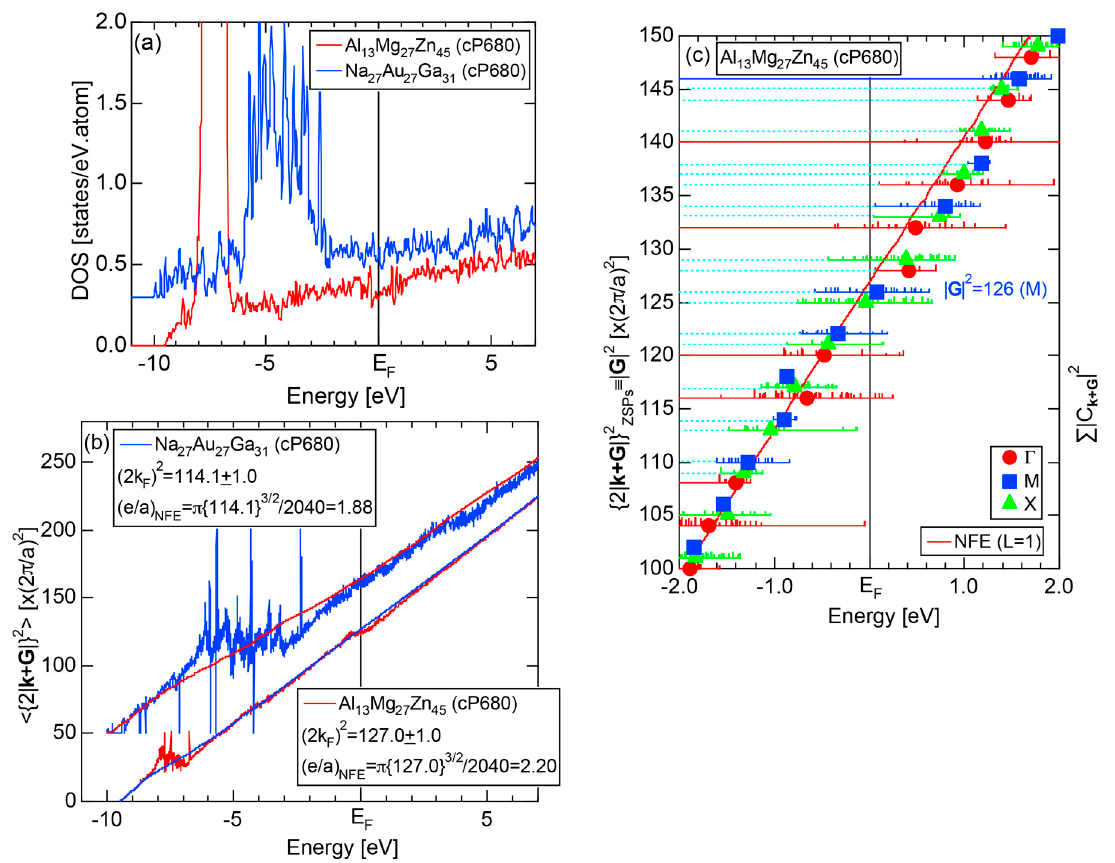
Figure 41. ( a ) Total DOSs; ( b ) Hume-Rothery plots and ( c ) FLAPW-Fourier spectra at symmetry points Γ , M, X of simple cubic Brillouin zone for Al 13 Mg 27 Zn 45 (cP680) (red) and Na 27 Mg 27 Zn 45 (cP680) are shown in ( c